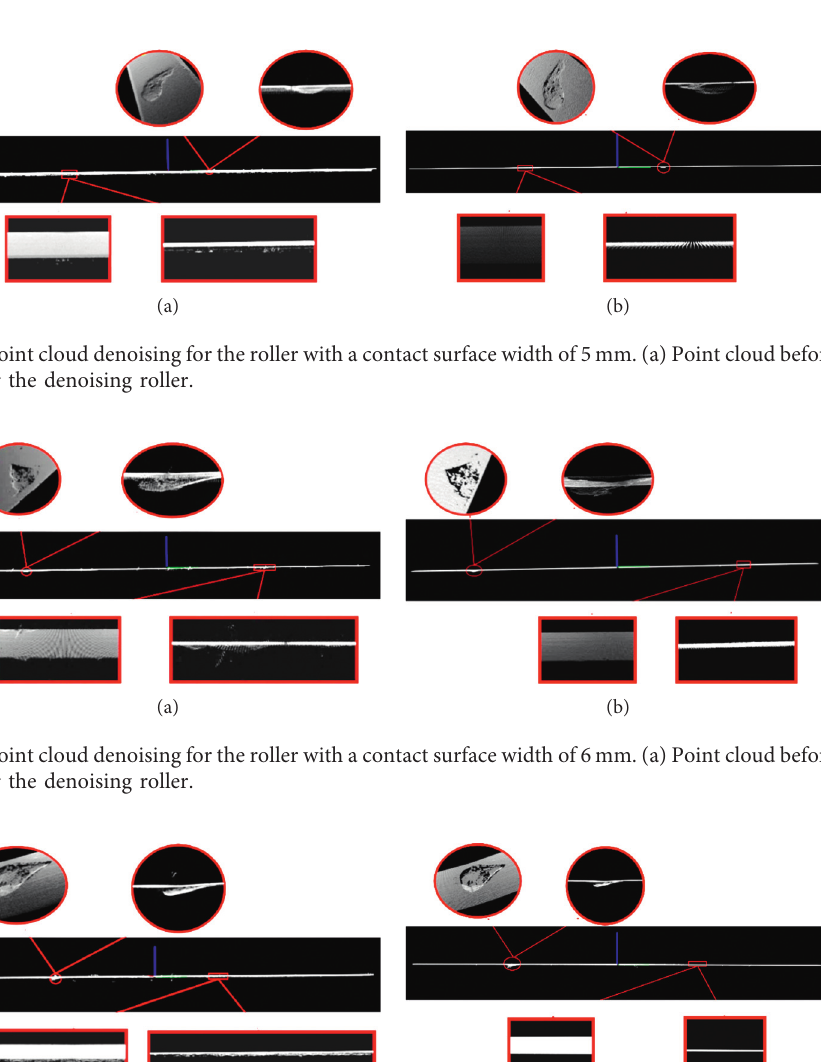
Figure 5: The results of point cloud denoising for the roller with a contact surface width of 4 mm. (a) Point cloud before the denoising roller and (b) point cloud after the denoising